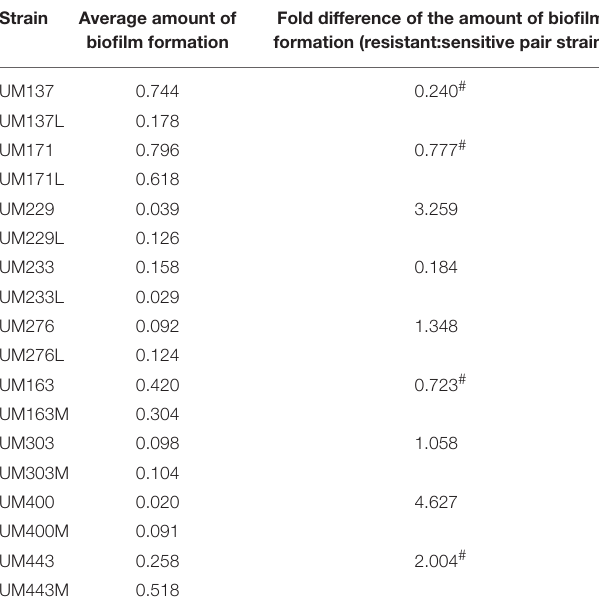
TABLE 3 | Average biofilm formation of H. pylori strains over 7 days of growth and the fold difference between resistant and sensitive pair strains.